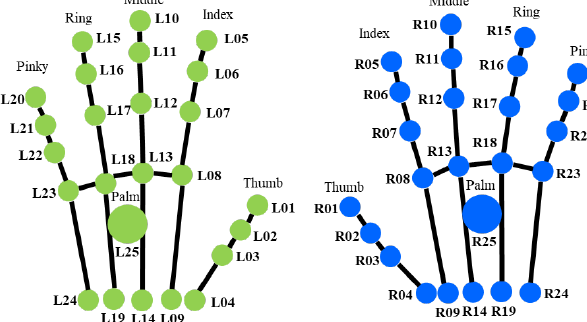
Figure 4. Finger joints.